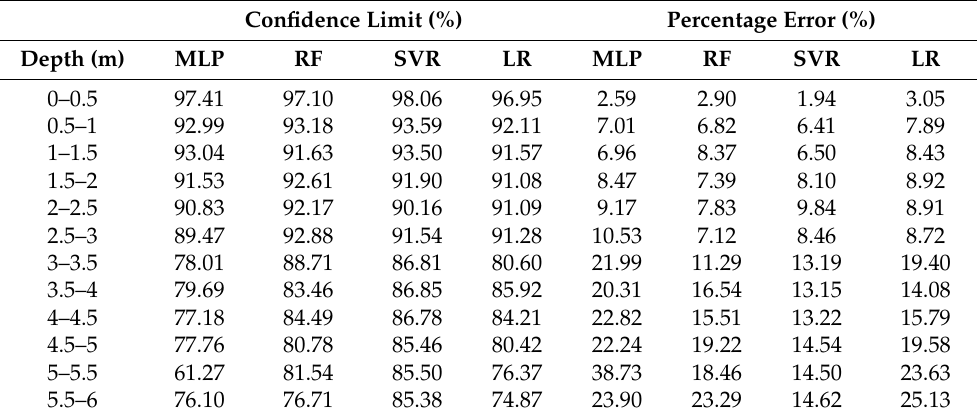
Table 4. Confidence limit and percentage error of the four algorithms. Confidence Limit (%) Percentage Error (%) Depth (m) MLP RF SVR